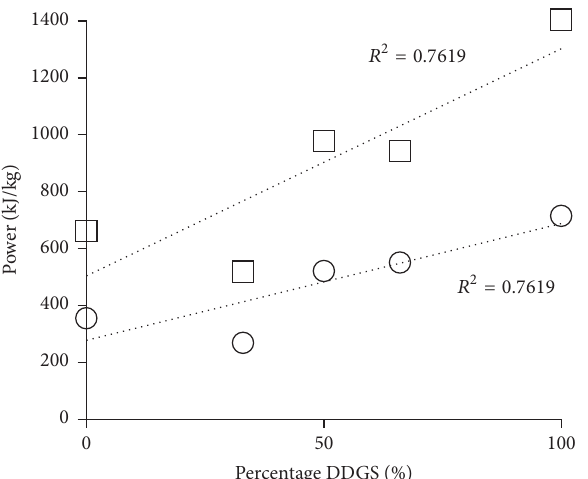
DDGS required more power, suggesting that, in the